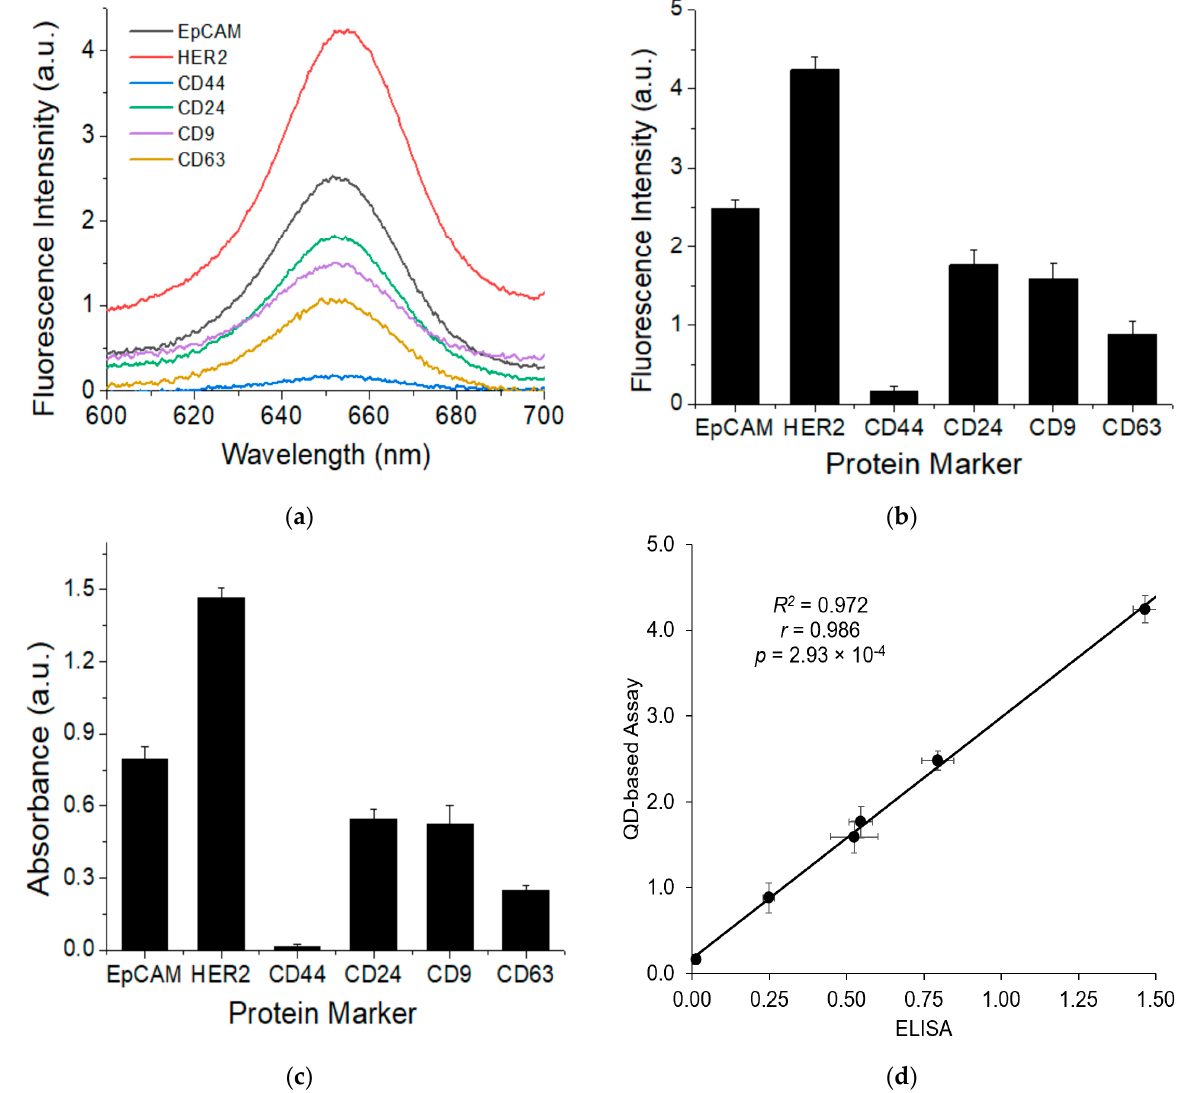
Figure 3. Comparison of QD-based assay and ELISA for the detection of exosome surface protein markers. ( a ) Fluorescence spectra of targeted markers on the surface of SKBR3 EXOs using the QD-based method. ( b ) Protein expression profile based on data in ( a ) at the mean intensity of 655 nm. ( c ) Protein expression profile of targeted surface markers on the surface of SKBR3 EXOs determined using ELISA. (d ) Comparison of QD-based assay with ELISA for measurement of protein expressions on exosomes. Error bar is the standard deviation from triplicate experiments.